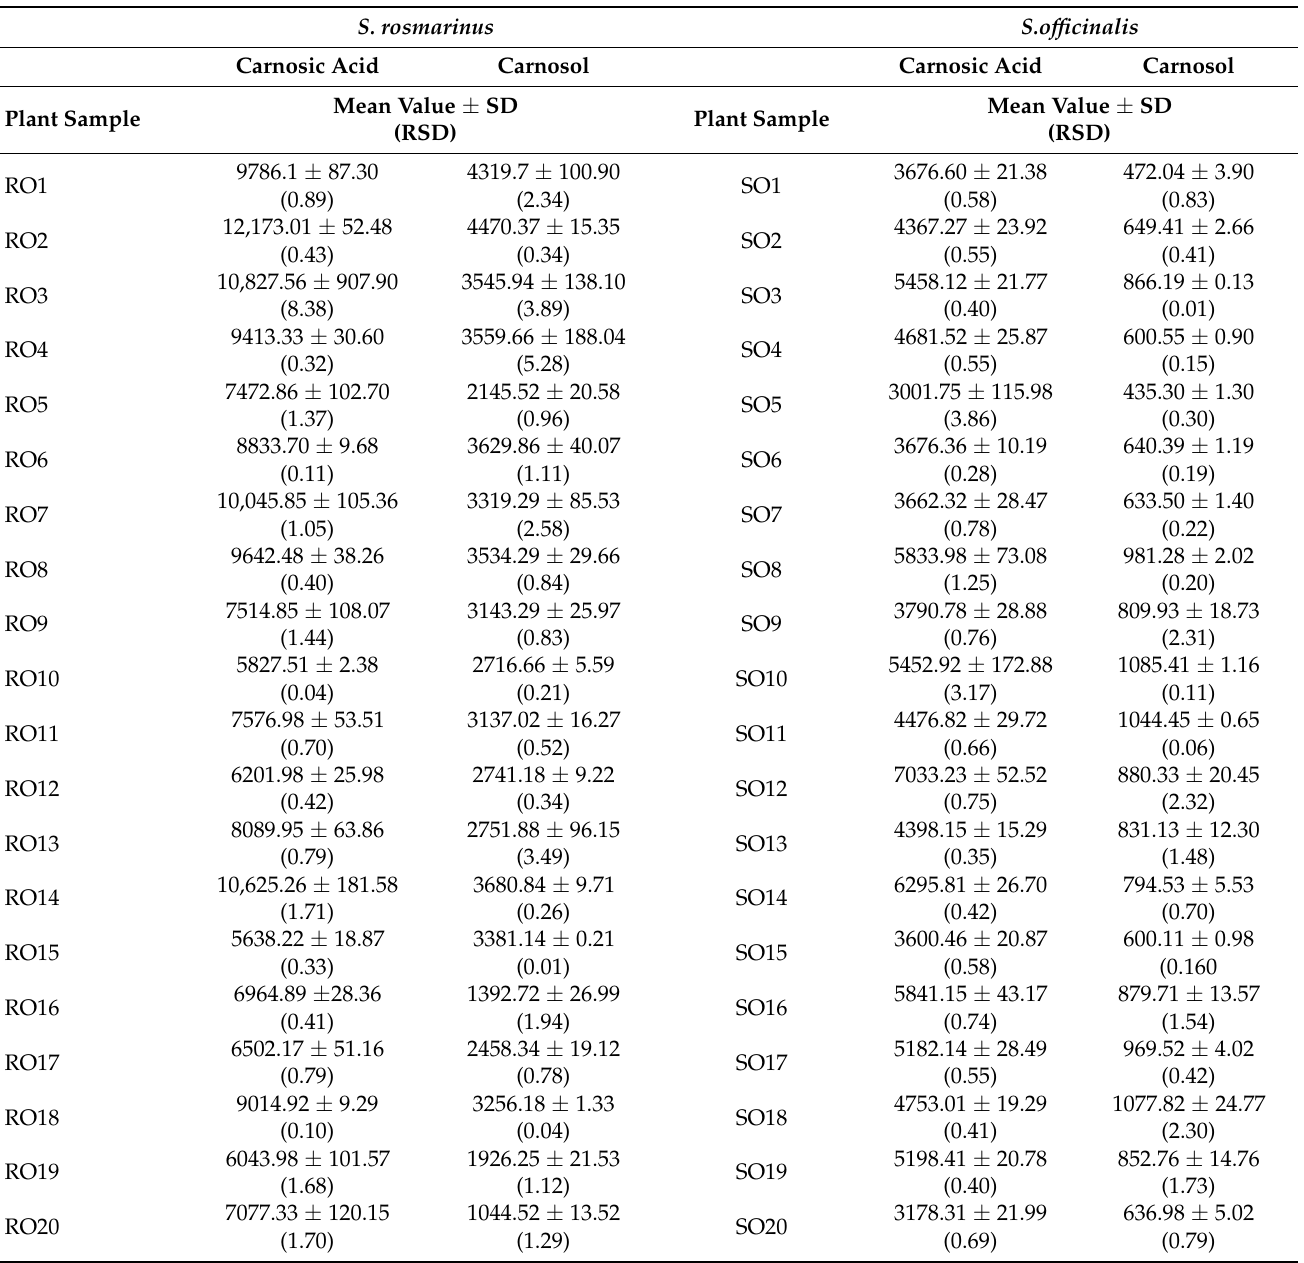
Table 3. Amounts of carnosic acid and carnosol expressed as µ g/g (fresh weight) in the samples of S. rosmarinus and S. officinalis leaves ( n =